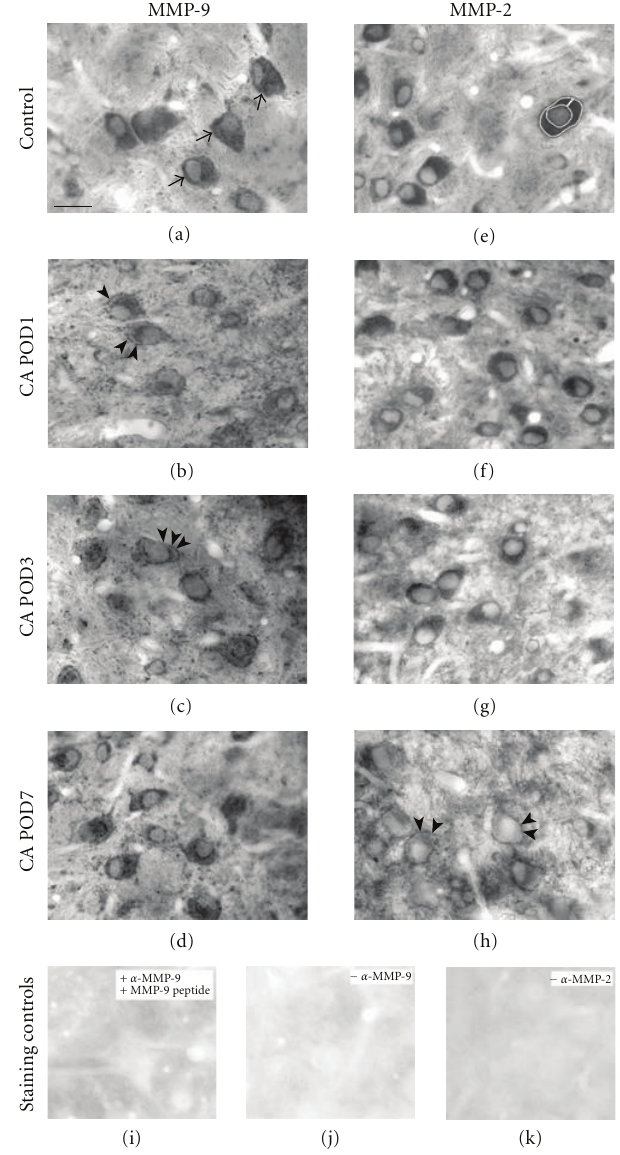
Figure 1: Time course and distribution of MMP-9 and MMP-2 realignments in AVCN on the side of cochlear ablation (CA), shown in 40 μ m thick sections stained with DAB and flat embedded in epon. (a) In AVCN of control animals, numerous neurons were strongly immunoreactive for MMP-9 in their cytoplasm (arrows). (b and c) By POD1 and POD3, MMP-9 immunoreactivity decreased in the cytoplasm of most neuronal somata. Beaded collars of MMP-9 immunoreactive particles emerged close to the plasma membrane (arrowheads). (d) By POD7, the pattern of MMP-9 staining has almost returned to control level (a). (e) MMP-2 was strongly expressed in the cytoplasm of AVCN neurons in control animals. The white line indicated around the cytoplasm of one neuron shows the sample field for quantitative analysis of MMP-staining intensity in neuronal cytoplasm used to obtain the data shown in Figures 6 and 7(e). (f) By POD1, only marginal changes in MMP-2 staining were seen. A derangement seen in tissue texture is caused by disintegrating auditory nerve fibers. (g) By POD3, the content of MMP-2 in cytoplasm of AVCN neurons slightly decreased. (h) This decrease continued towards POD7 when beaded collars of MMP-2 positive particles became visible in direct vicinity to the cell’s plasma membrane (arrowheads). (i) and (h) Neutralization of the primary antibody prior to the staining procedure (i) and omission of the primary antibody against MMP-9 (j) verified specificity of the immunostaining. (k) Omitting incubation with antibody raised against MMP-2 resulted in failure of staining. Global contrast adjustment was identical for all photographs in this figure. Scale bar: 20 μ